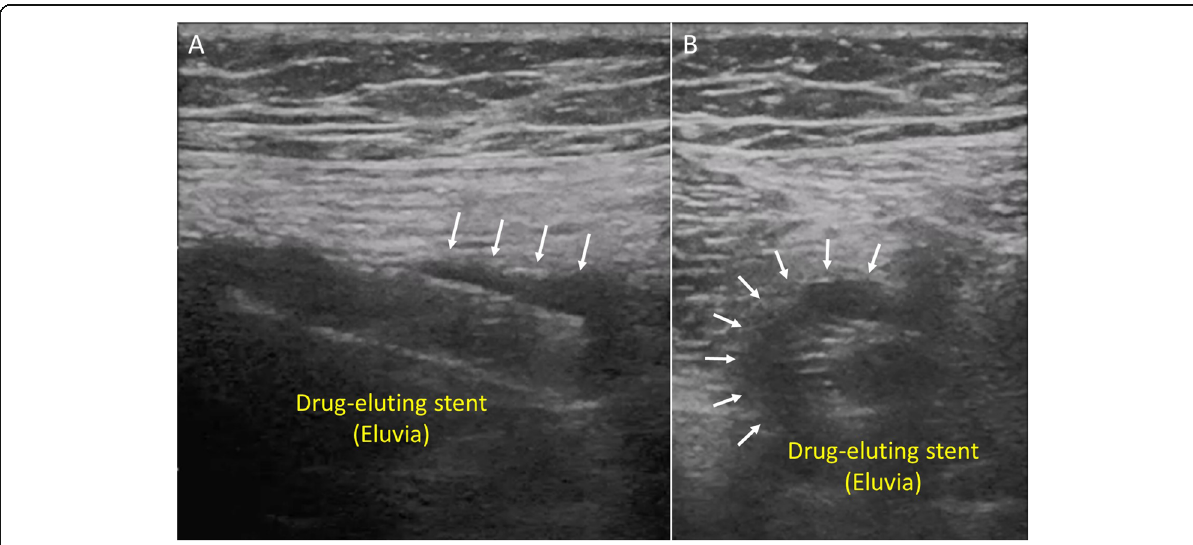
Fig. 3 Duplex images 50 months after drug-eluting stent (Eluvia) placement. Duplex images showing a hypoechogenic halo around the distal edge of the drug-eluting stent (Eluvia) ( a and b